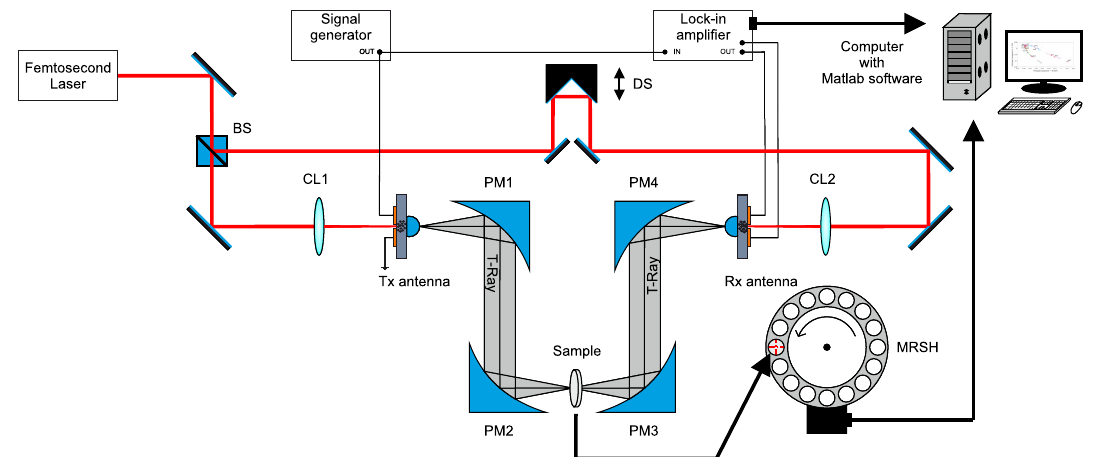
Figure 1. Terahertz system for the recognition of bi-heterocyclic